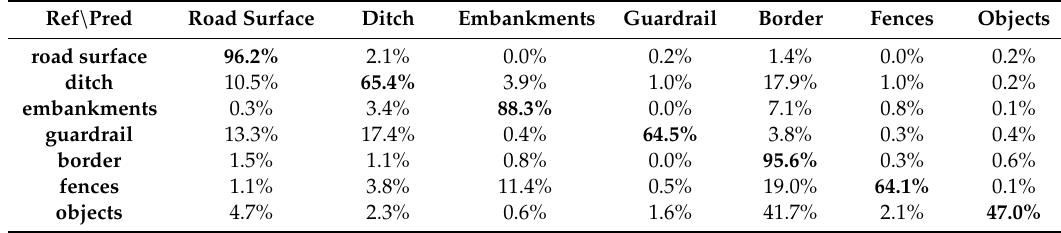
Table 2. Confusion matrix in true positive